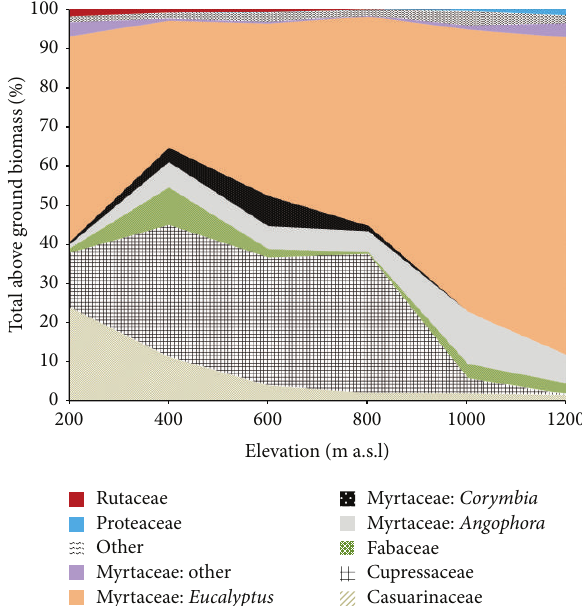
Figure 6: Variation in the contribution of major taxonomic groups to above ground biomass (AGB) across an altitudinal gradient in eastern